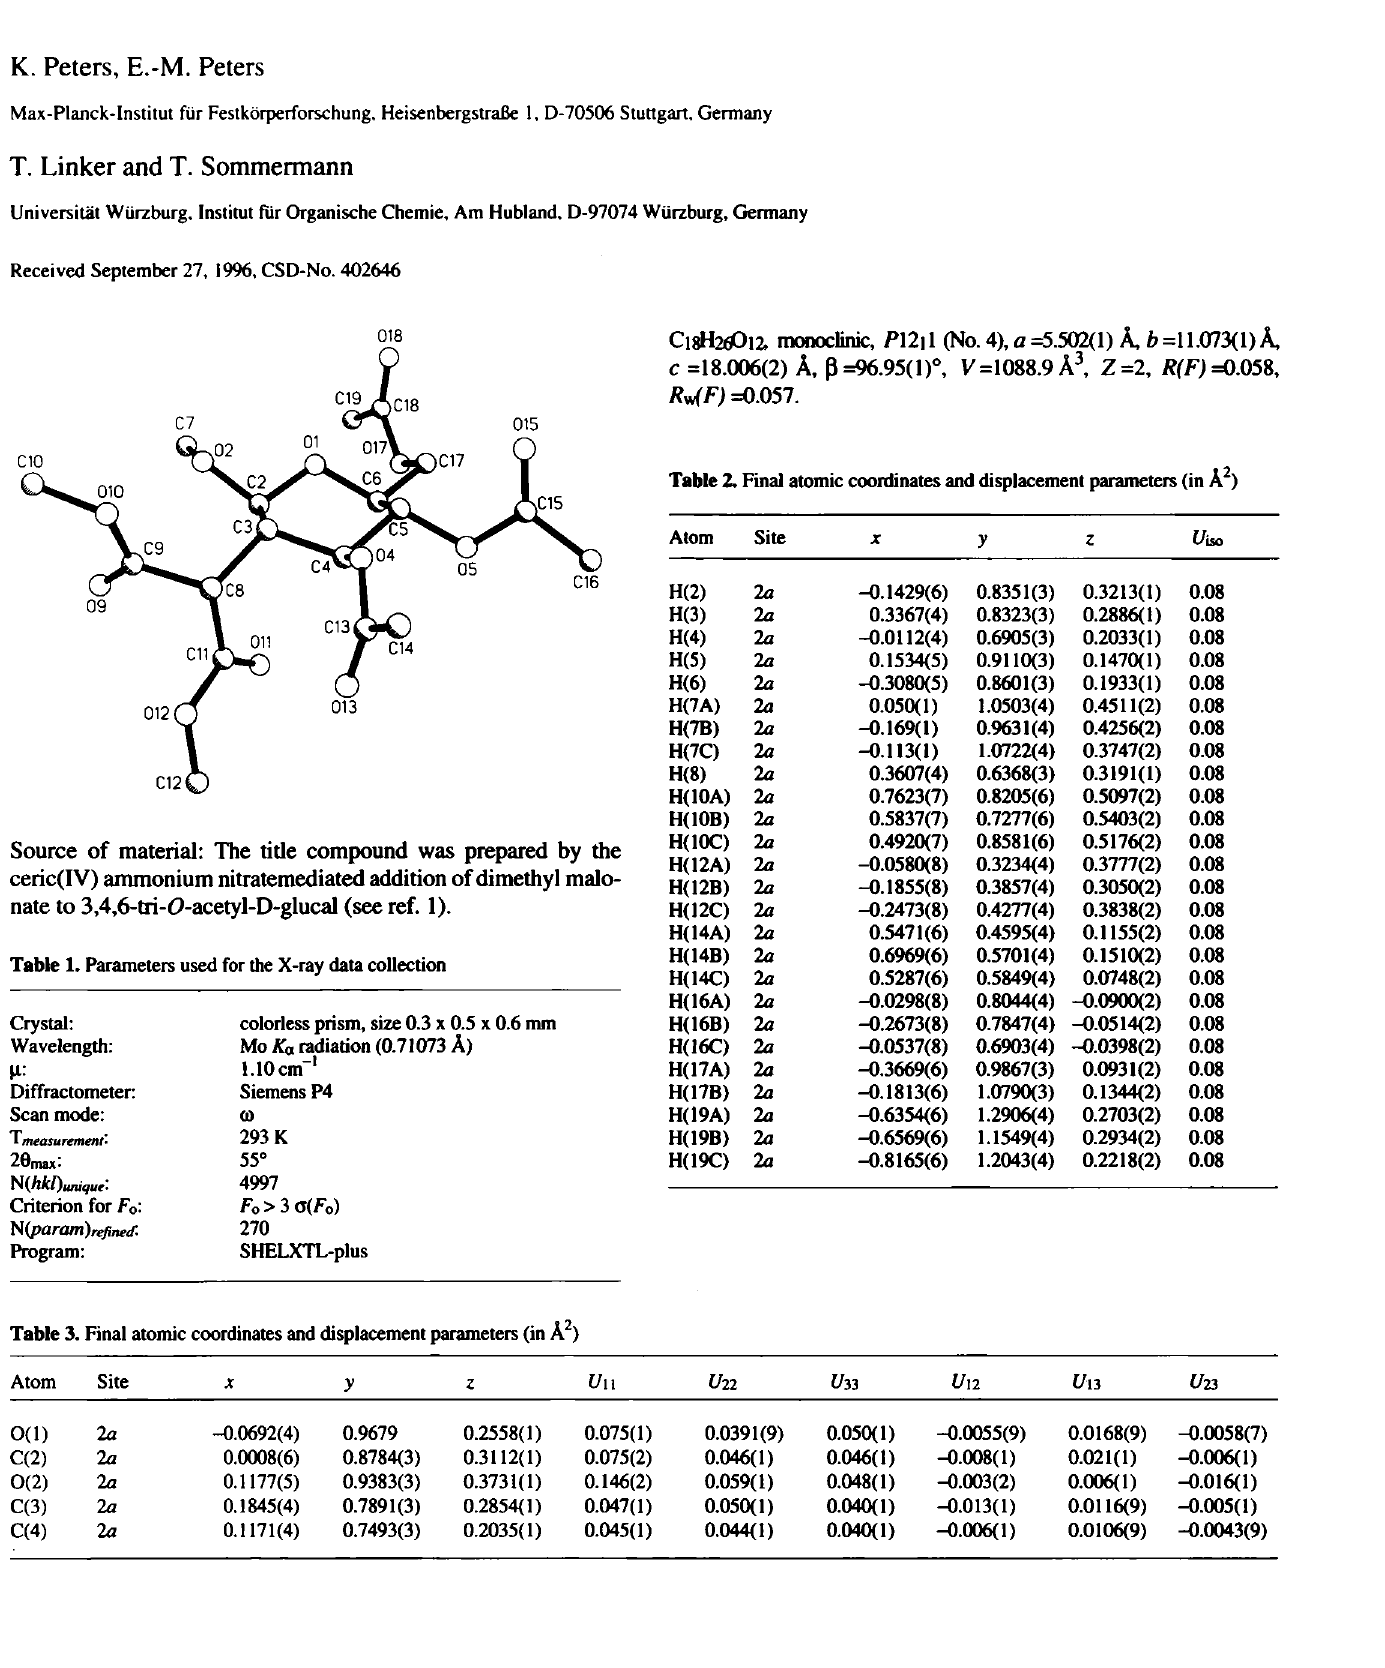
Table 2. Final atomic coordinates and displacement parameters (in À 2 )